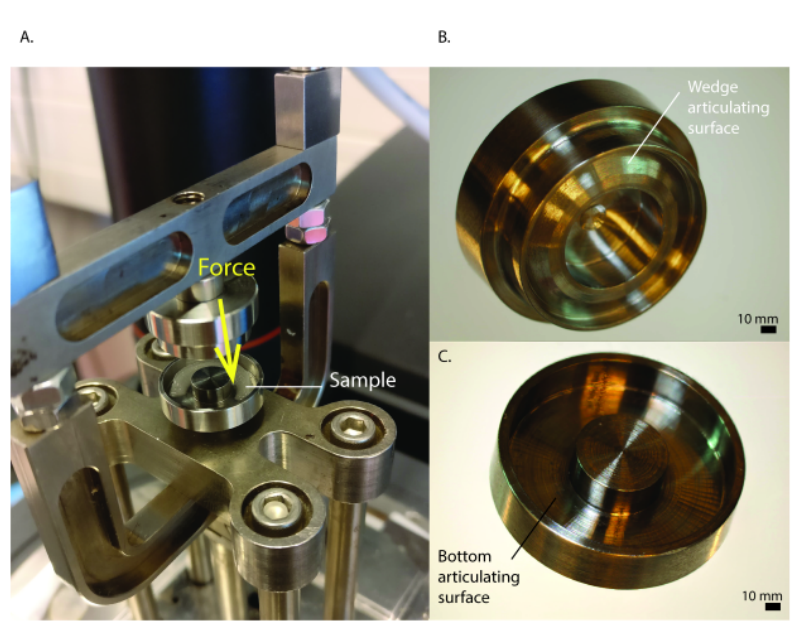
Figure A1. Mechanical characterization of scaffolds. ( A ) Compressive testing system, ( B) Custom made scaffold holder for compression of the wedge surface (top) and ( C ) Custom made scaffold holder for compression (bottom).